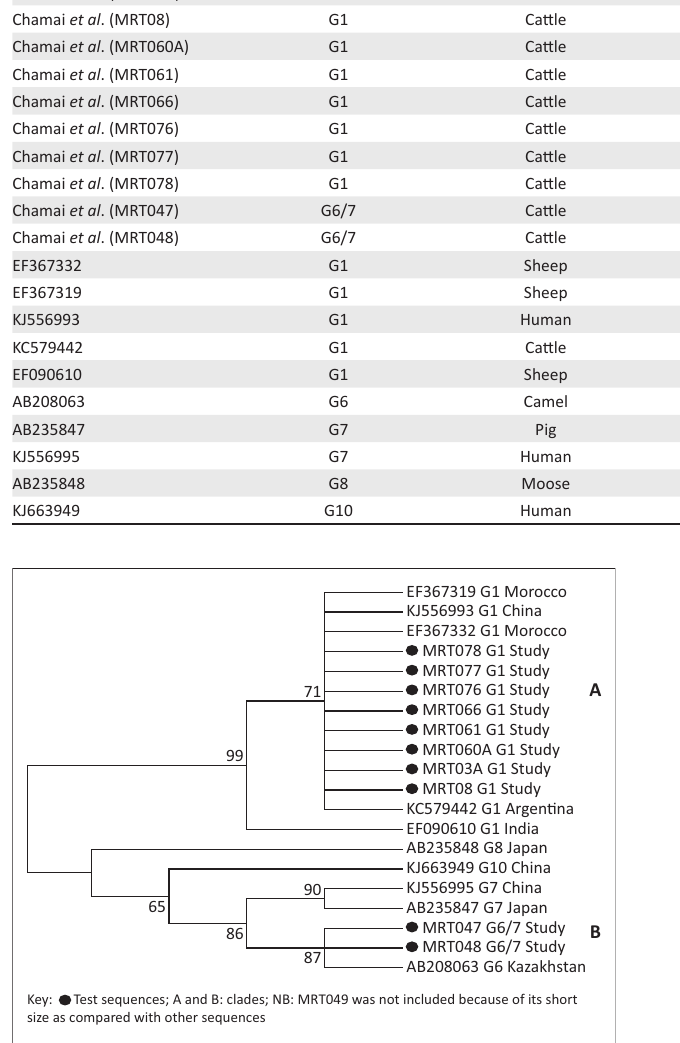
FIGURE 4: Molecular phylogenetic analysis of test isolates along with National Centre for Biotechnology Information published sequences by Maximum Likelihood